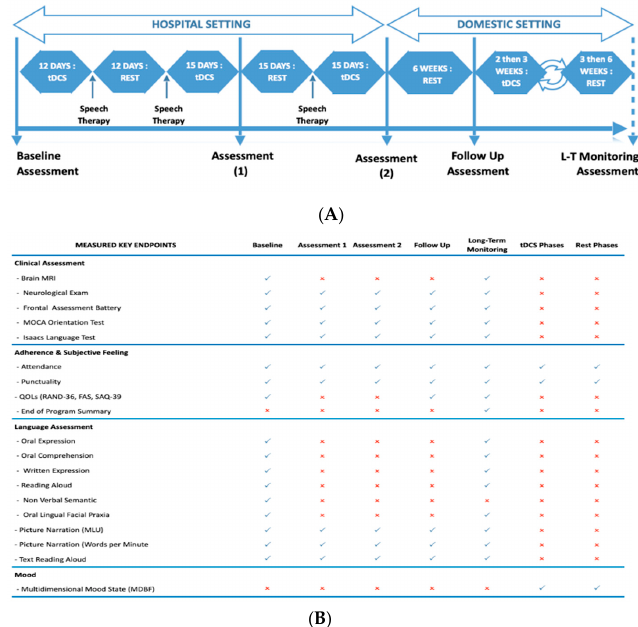
Table 1. Language evaluation.